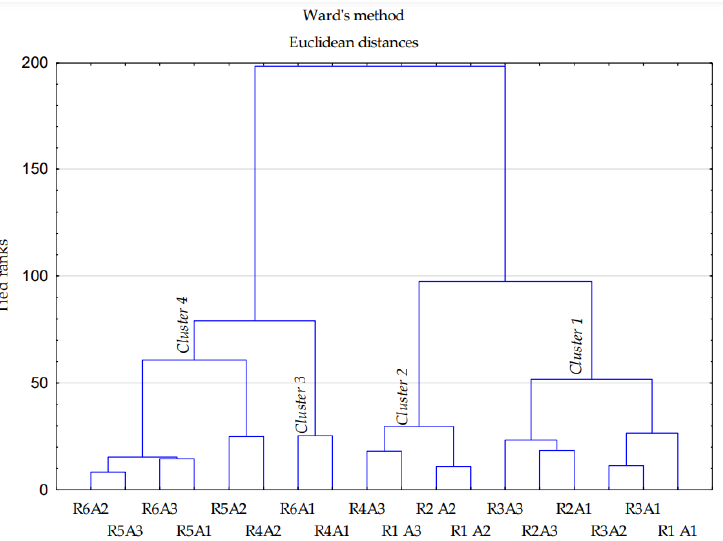
Figure 6. Dendrogram analysis of physicochemical and microbial soil characteristics (abbreviations: see Table 1).